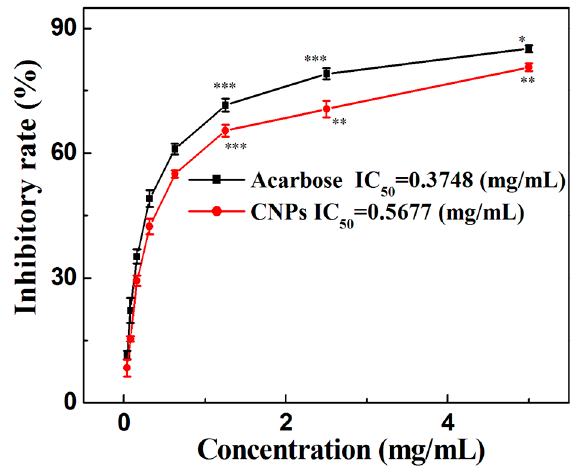
Figure 3. Inhibitory e ff ects of the as-prepared CNPs and acarbose on α -glucosidase activity. Data ware expressed as mean ± standard deviation ( n = 3), * p < 0.05, ** p < 0.01, *** p < 0.001 vs. blank control.